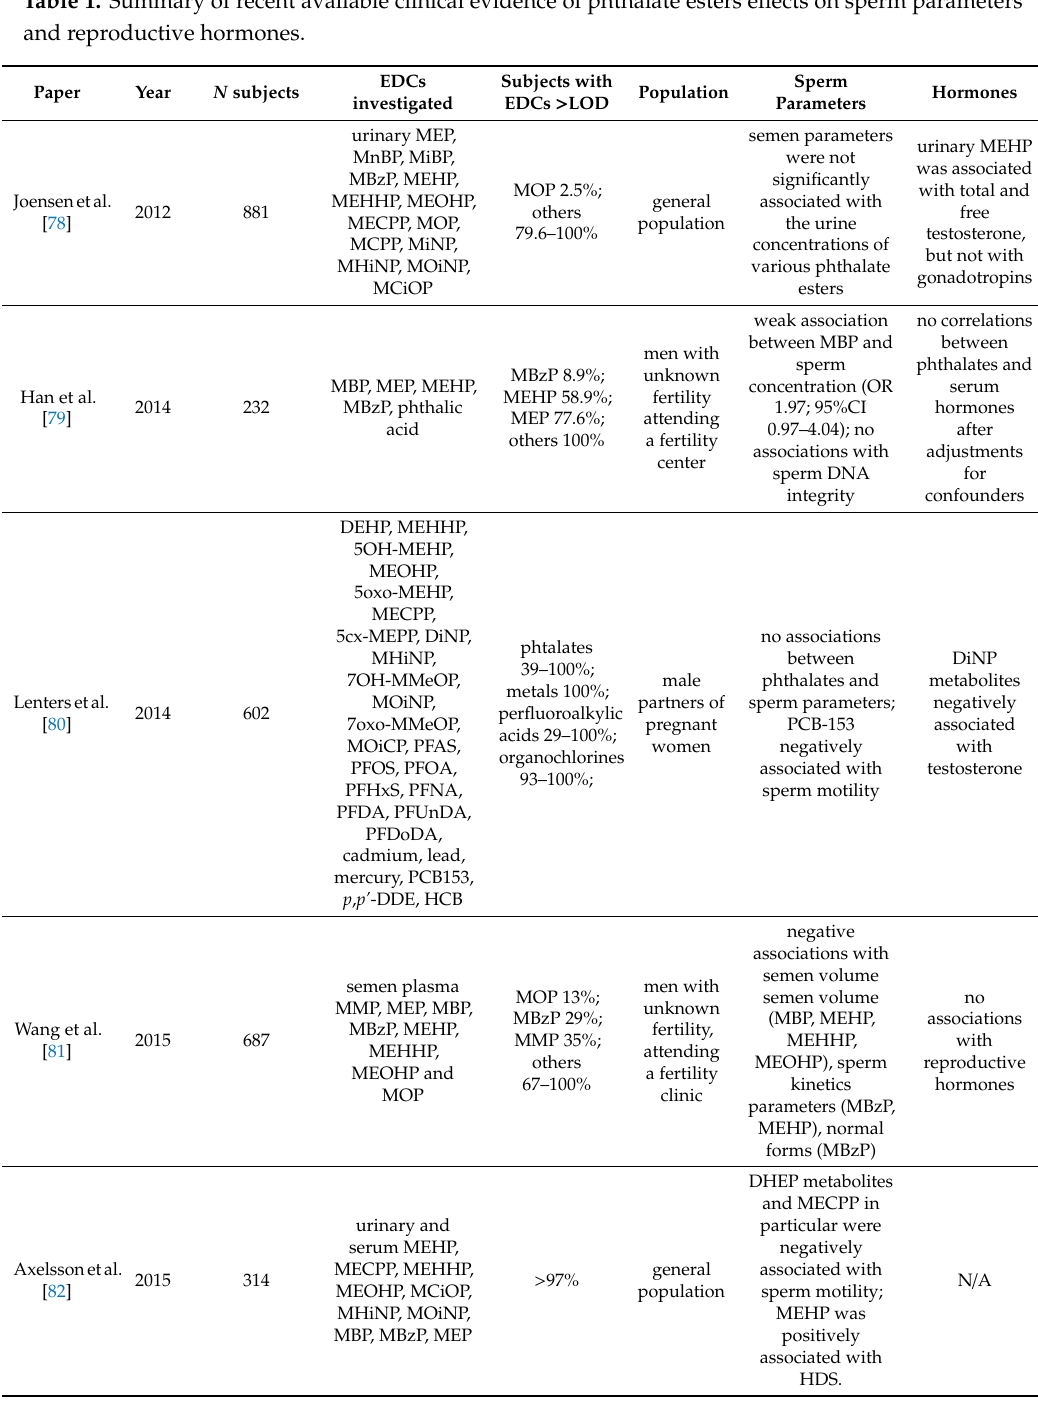
Table 1. Summary of recent available clinical evidence of phthalate esters e ff ects on sperm parameters and reproductive